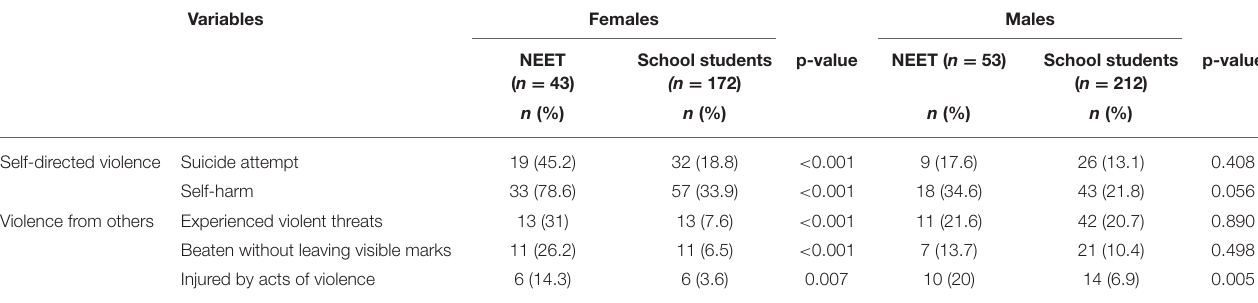
TABLE 1 | Comparisons of violent experiences according to NEET status and sex.